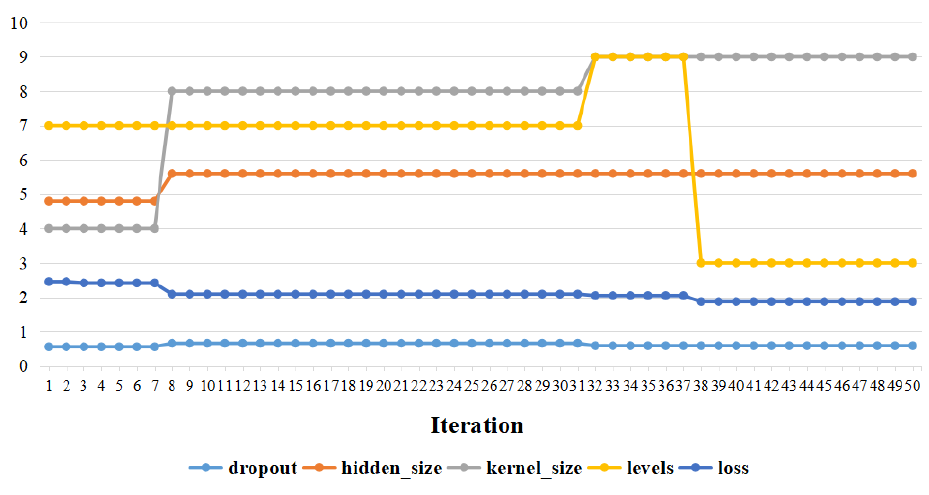
Figure 9. The Bayesian optimization process of hyperparameters.